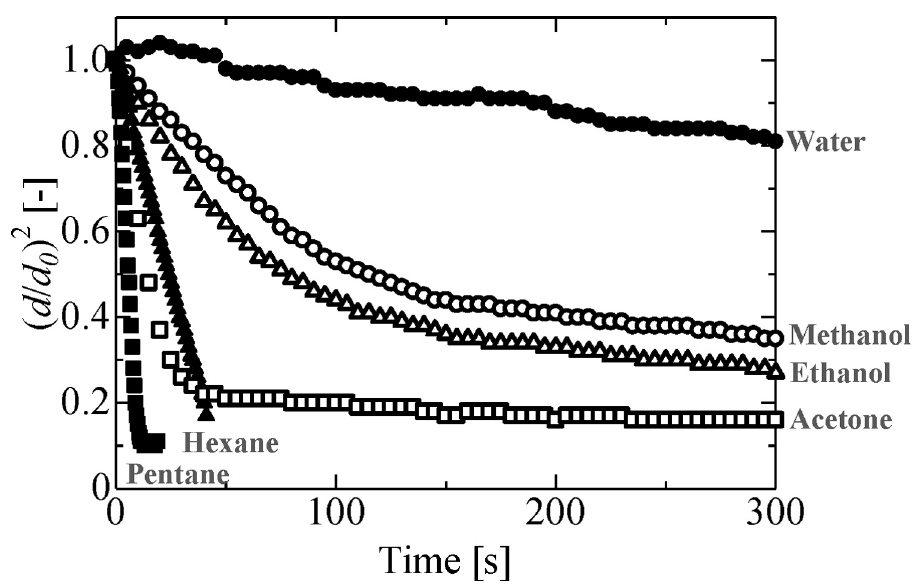
Fig 3. Evaporation process of the levitated pure droplet. Water: d 0 = 1.4 mm, P rms = 1.8 kPa, b/a = 1.2, P s = 3534 Pa, Ethanol: d